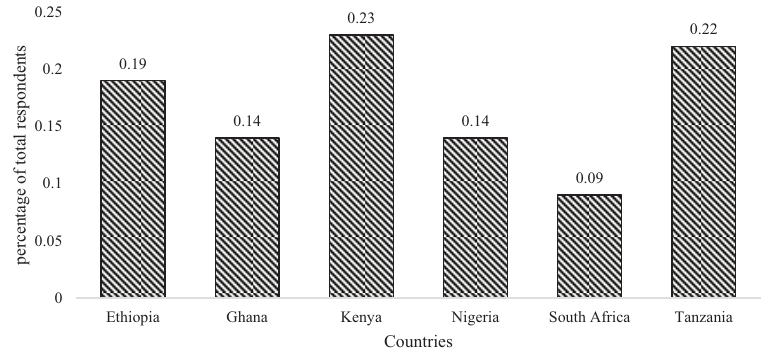
Figure 1. Perceived